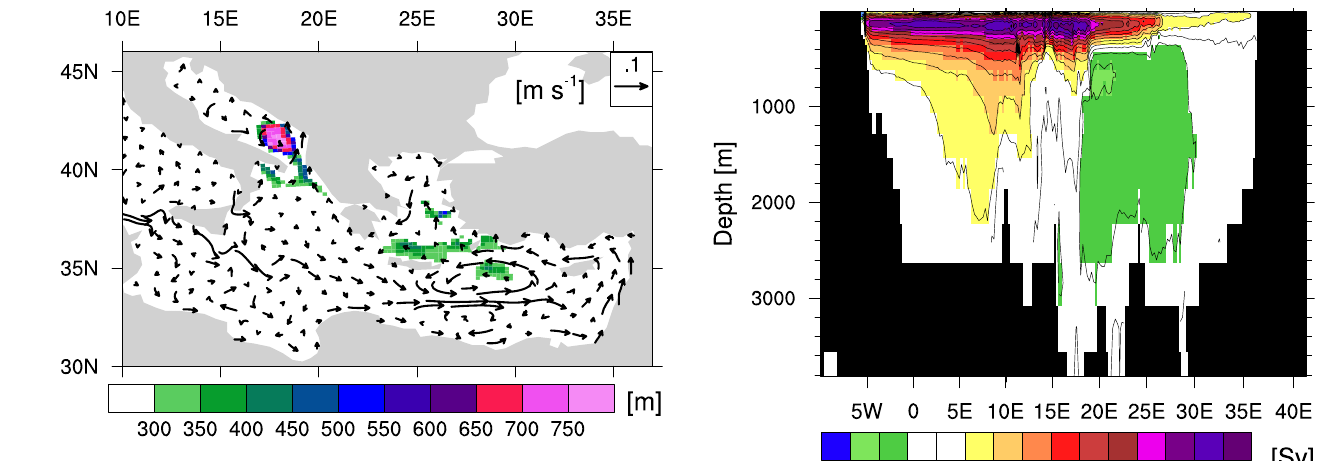
Fig. 3. Modelled March mixed layer depth (colours) and near- surface currents field (arrows) at 27m depth for CTRL. Only a sub- set of vectors has been plotted. The mixed layer depth is reached when the density difference between this depth and the surface ex- ceeds 0.125kgm − 3 . Note that such a calculation can only give an approximative estimate of the depth of the mixed layer.